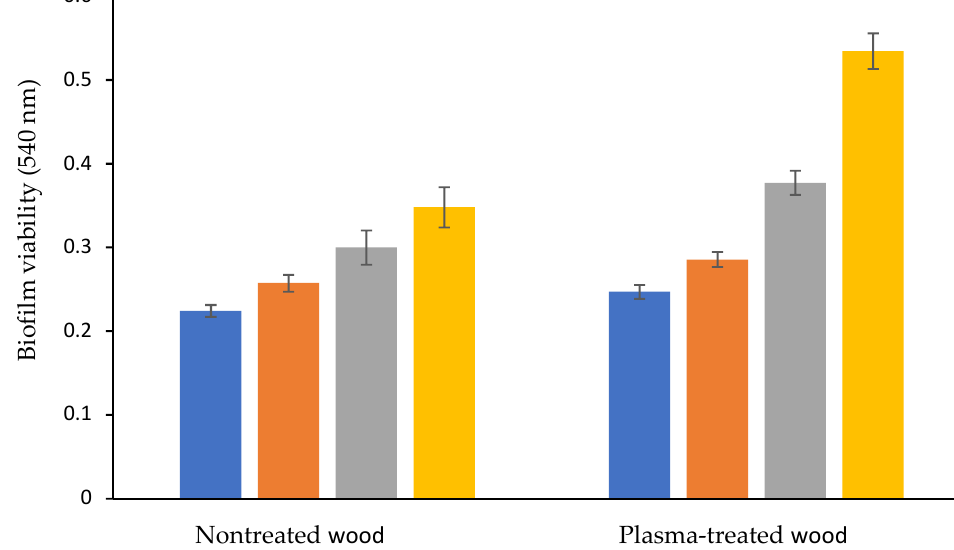
Figure 2. Biofilm viability on plasma-treated ( right ) and nontreated ( left ) wood waste. Measured on the 2nd (blue), 3rd (orange), 4th (grey), and 7th (yellow) day.